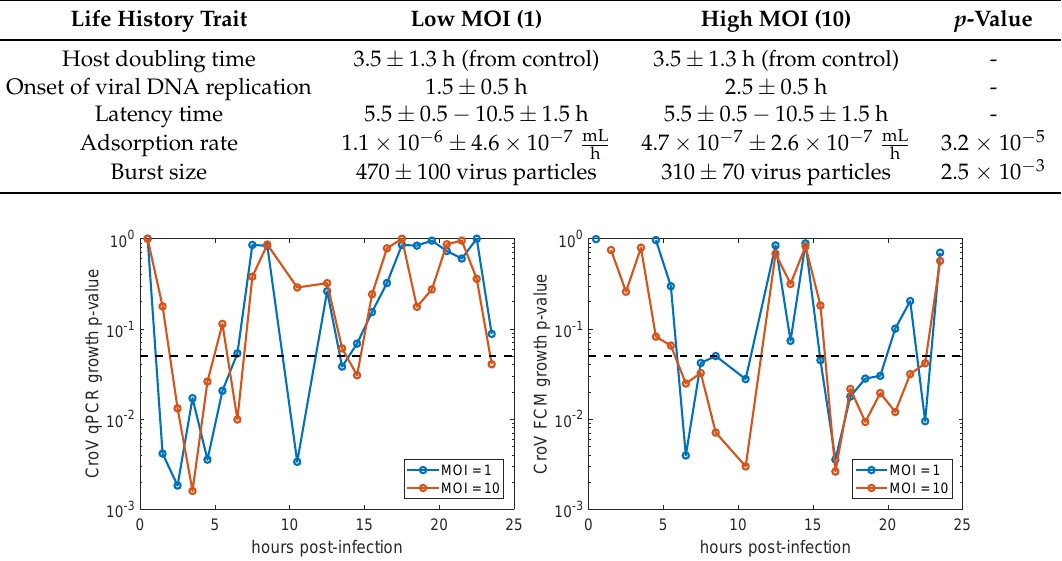
Figure 4. Significance values for identifying virus production. For a given datapoint at the plotted time, lower p -values correspond to higher probability of viral production between the current and previous time point with p = 0.05 noted in dotted black line. ( Left ) Viral DNA copies increase as measured by qPCR. ( Right ) Extracellular viral particle increase as measured by